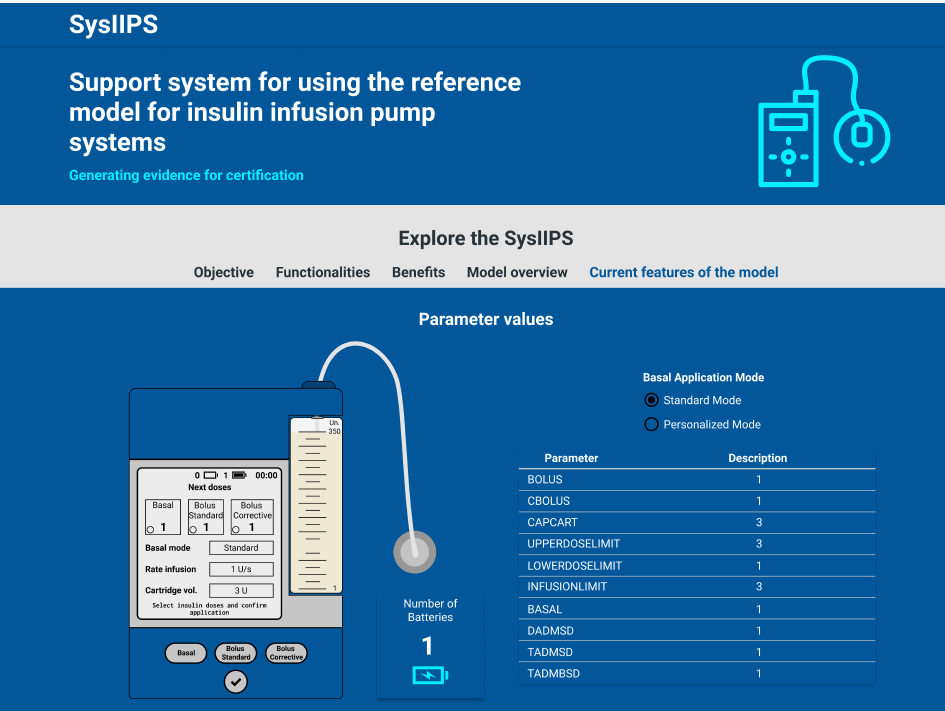
Figure 16. GUI sample of the web-based application for insulin infusion pump